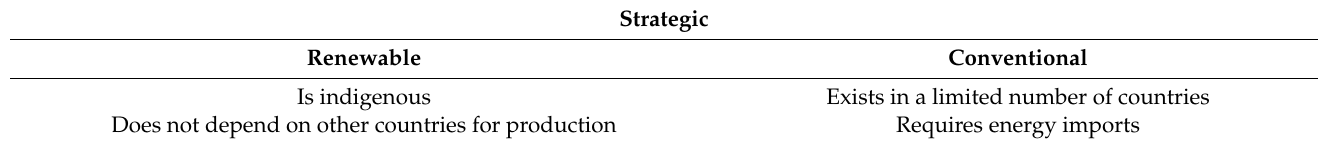
Table 2. Strategic advantages.